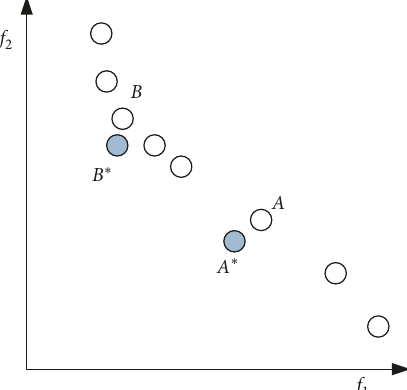
Figure 1: Illustration of motivation 1 : suppose solutions A and B are two nondominated solutions. The neighborhood size is 5, and the neighborhood consists of 5 closest solutions in objective space. A ∗ and B ∗ are two potential dominating solutions. It is very likely that A has a lower chance to generate A ∗ by randomly selecting two parents in its neighborhood since A ’s neighbors are far from each other. In this figure, the minimization problem is considered.